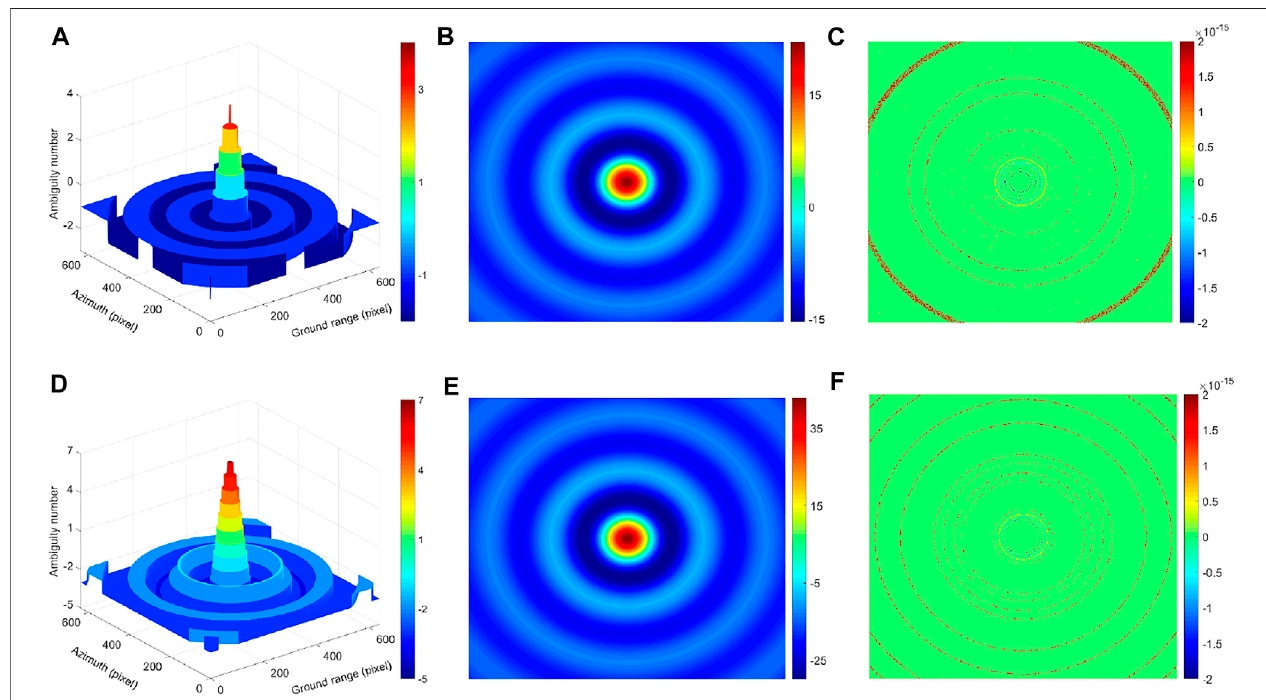
FIGURE11|(A) 3Dmapofthesolvedambiguitynumbersforshort-baselineinterferogram. (B) Unwrappingresultsforshort-baselineinterferogram(rad). (C) Phase error distribution map for short-baseline interferogram (rad). (D) 3D map of the solved ambiguity numbers for long-baseline interferogram. (E) Unwrapping results for long-baseline interferogram (rad). (F) Phase error distribution map for long-baseline interferogram (rad).